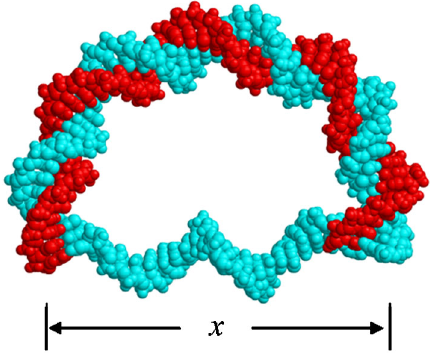
FIG. 1. Cartoon of a stressed DNA molecule used in the experiments. The ds DNA is from the Protein Data Bank (PDB) structure 1KX5, and the ss DNA is from PDB 1BNA. The molecule is formed by partially hybridizing a ss DNA loop (blue) with a linear complementary strand (red). The elastic energy of this molecule consists of the bending energy of the ds part and the stretching energy of the ss